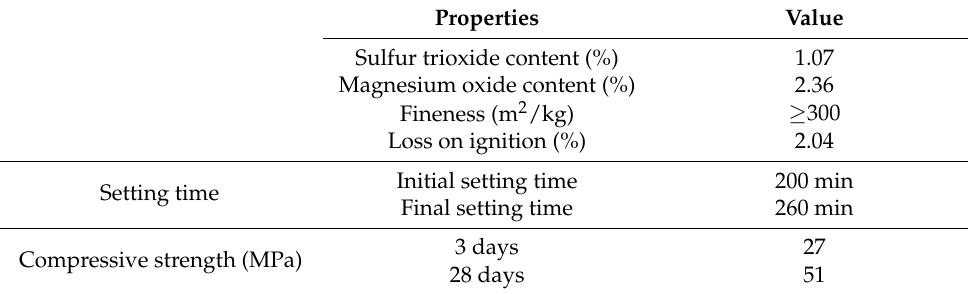
Table 1. Physical properties of Portland cement.